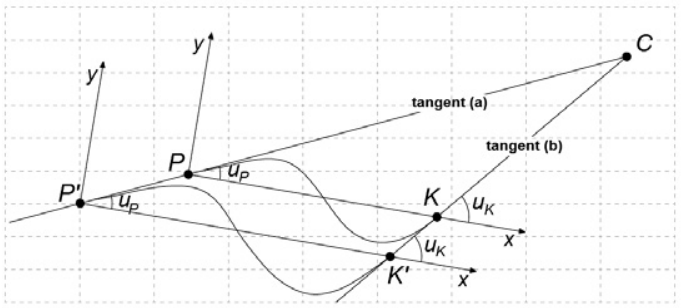
Figure 5. The second option: S -shaped transition curve connecting given points P and